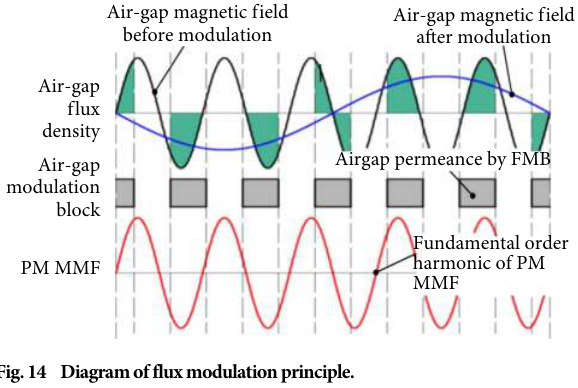
Fig. 14 Diagram of flux modulation principle.